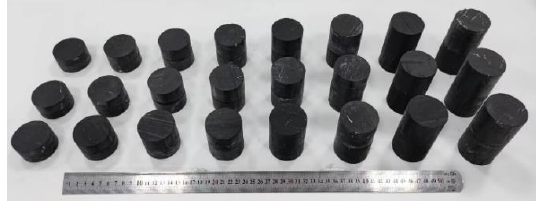
Figure 1. Coal samples.